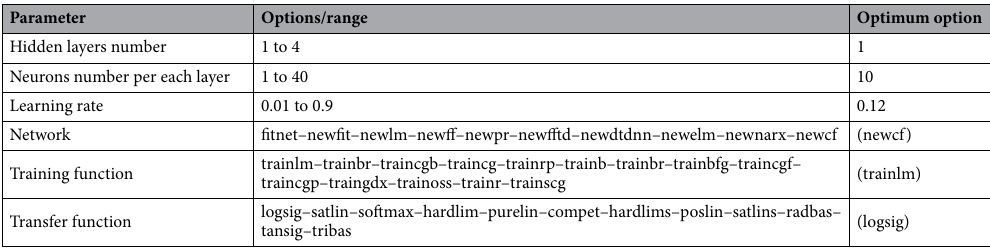
Table 3. Parameters optimization process.